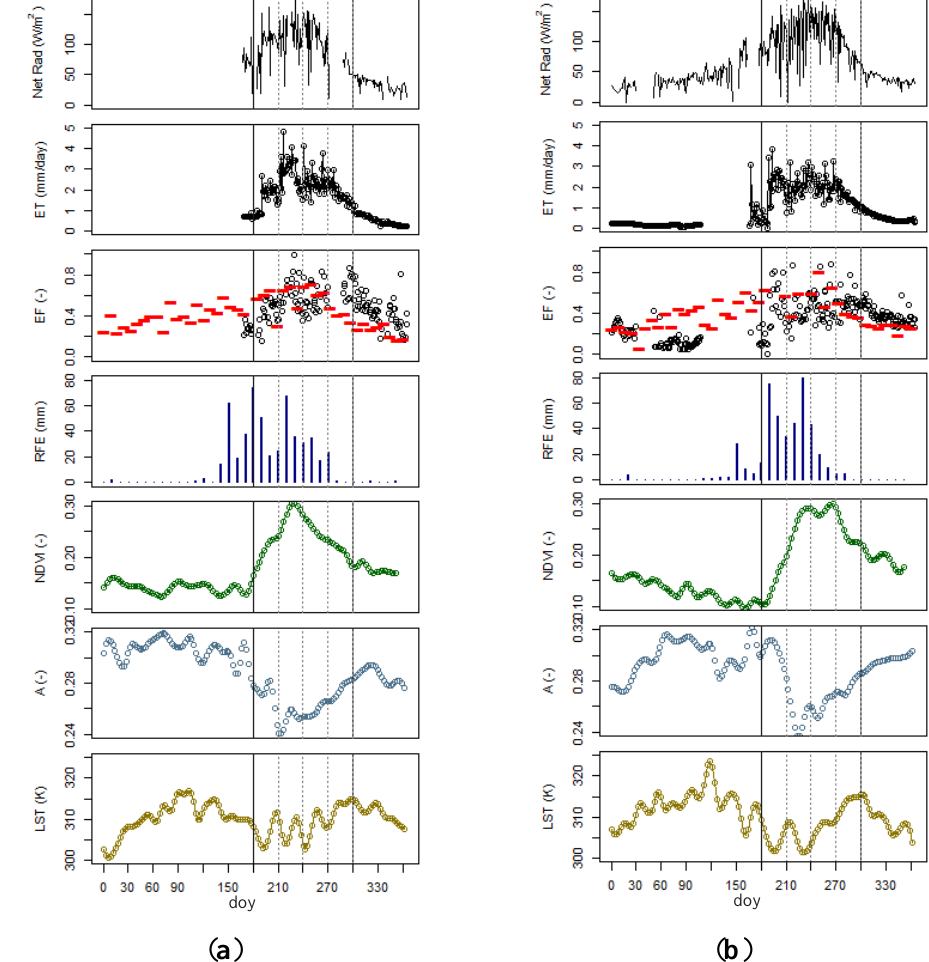
Figure 7. From top to bottom, the temporal behavior of daily net radiation; daily evapotranspiration; EF-derived from the eddy covariance tower data at the Wankama site (black lines) together with eight-day EF estimation from MODIS data (red dashes); decadal NDVI-VGT (green line); decadal precipitation (blue bars), eight-day MODIS albedo (gray line) and eight-day MODIS temperature (yellow line) for 2005 ( a ) and 2006 ( b ). Vertical lines represent the start and finish of the JASO period, doy the Day Of the